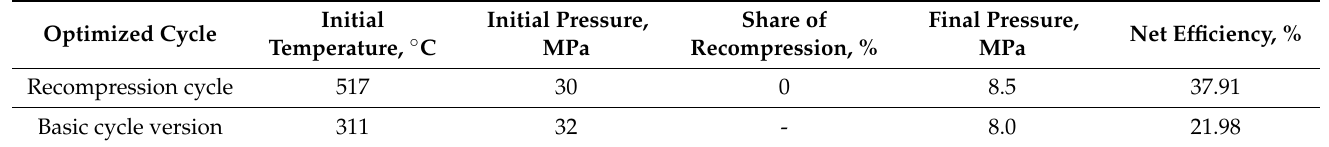
Table 3. Main characteristics and parameters for the calculation of thermal schemes.